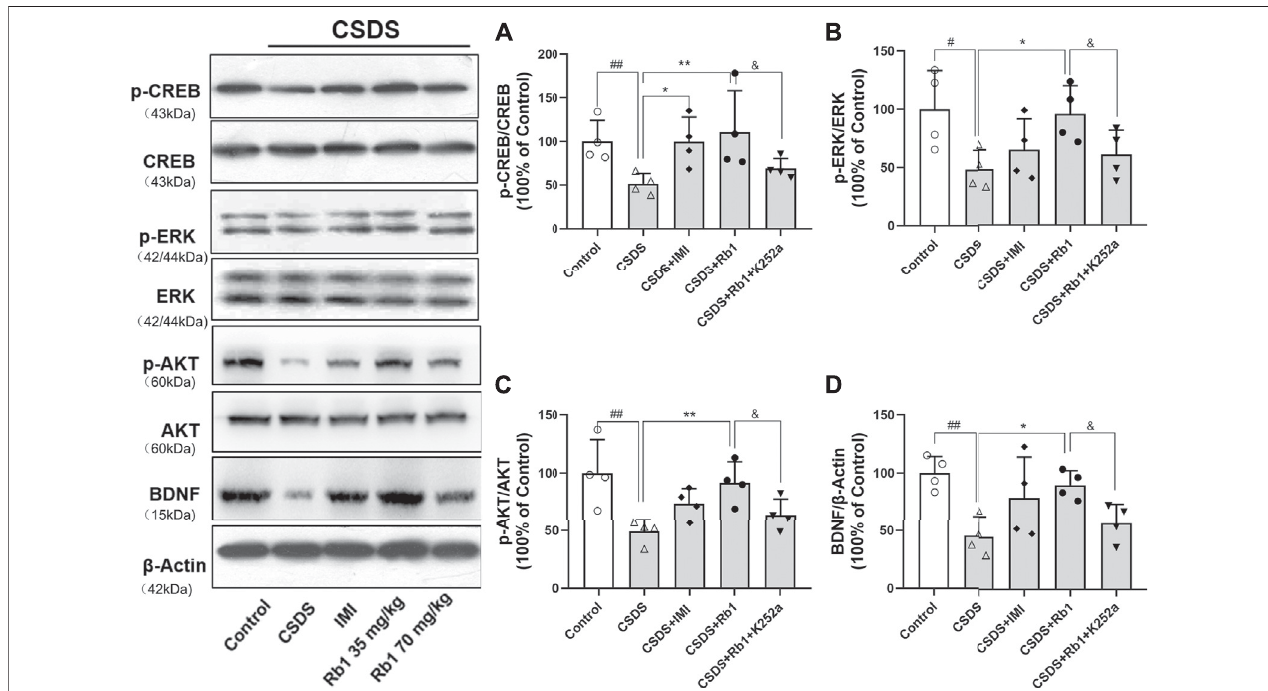
FIGURE 7 | Impact ofpretreatment with K252a on Rb1-activated BDNF. The in fl uence of SY on the pCREB/CREB (A) , pERK/ERK (B) , pAKT/AKT (C) , and BDNF (D) protein levels in the hippocampus of the rats exposed to CUMS. The results have been indicated as means ± SEMs (n (cid:2) 4). # p < 0.05, ## p < 0.01, vs. the control group; * p < 0.05, ** p < 0.01, vs. the model